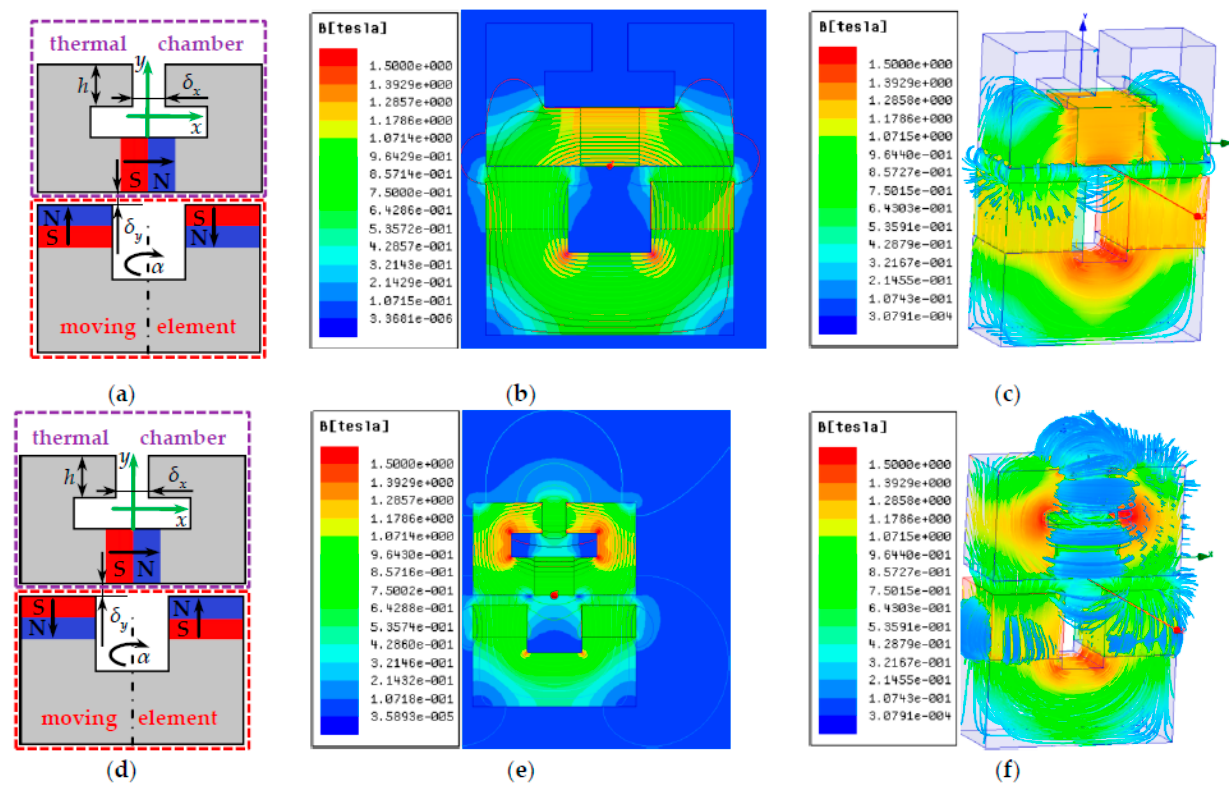
Figure 5. The structure of the exciter with additional δ y gaps and a rotating yoke with permanent magnet at positions corresponding to: ( a ) switched “off” and ( d ) switched “on” magnetic field in the gap δ , as well as the 2D ( b , e ) and 3D ( c , f ) magnetic field distributions determined for these operating states.